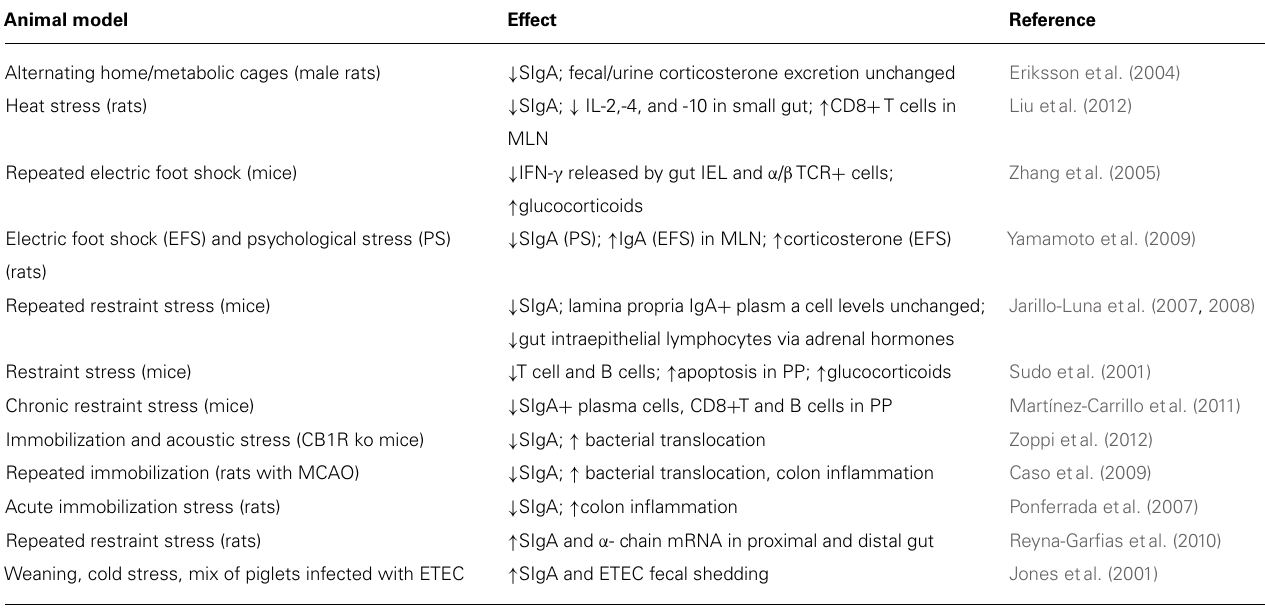
Table 1 | Impact of stress on intestinal